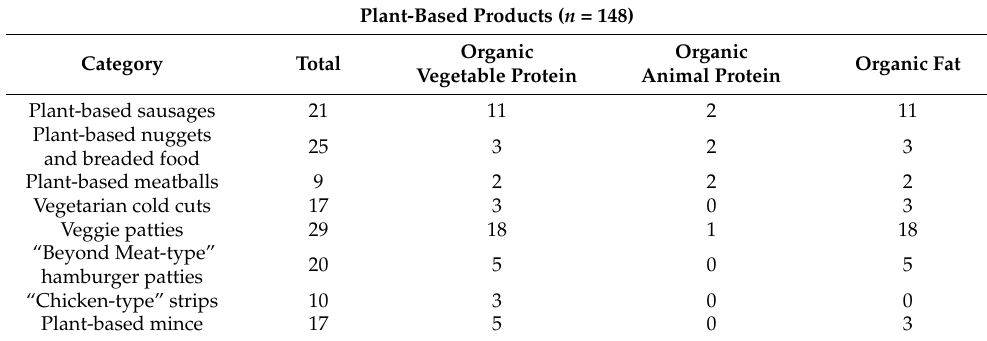
Table 5. Plant-based meat alternatives categories with an organic